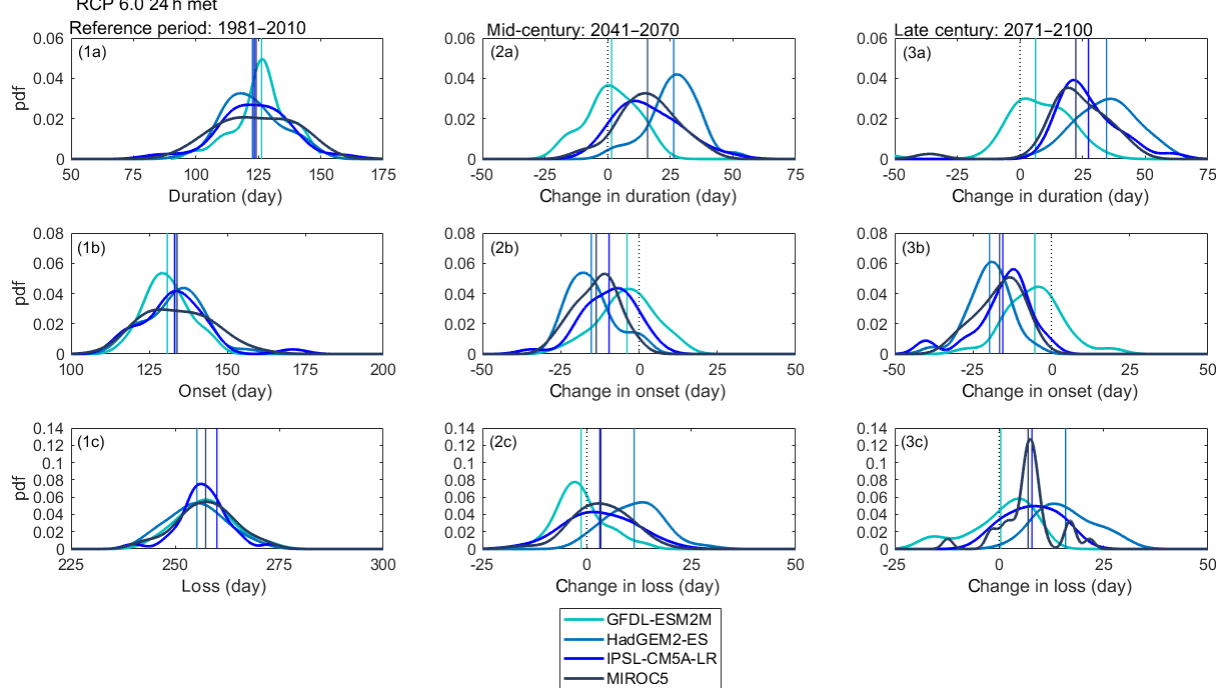
Figure 7. Changes in annually averaged thermal metrics (from April to September) for (2a, 3a) duration and (2b, 3b) onset and (2c, 3c) loss of stratification under RCP6.0 and showing results from when the lake model was forced with daily GFDL–ESM2M, HadGEM2–ES, IPSL– CM5A–LR, and MIROC5 projections. All changes for the mid-century (2041–2070) and the late century (2071–2100) are relative to the reference period (1981–2011). The mean (vertical line) is also shown. Changes in thermal metrics greater than 0 show an increase and lower than 0 show a